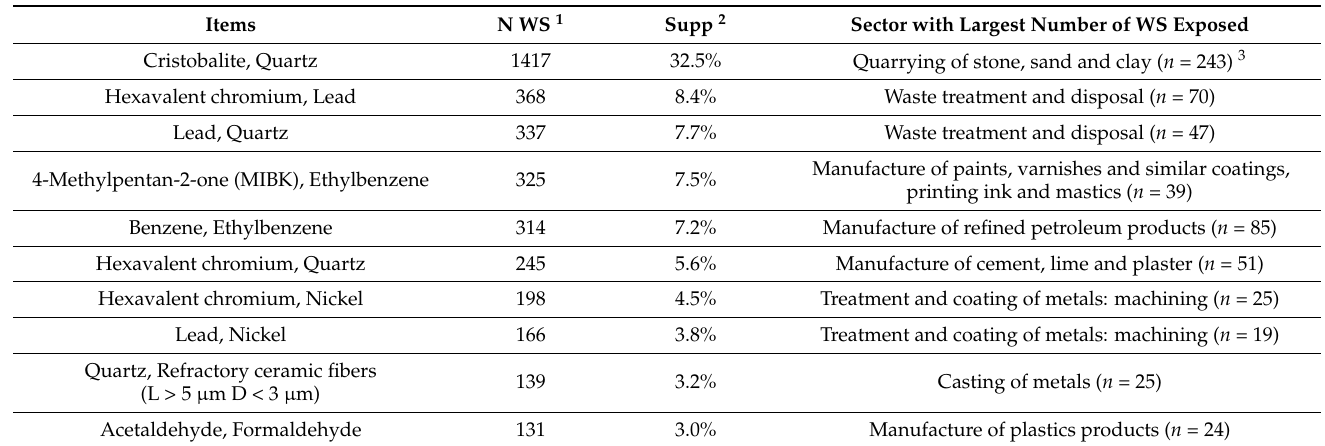
Table 6. List of the 10 frequent itemsets of carcinogens with the highest level of support among WS exposed to at least 2 different agents.